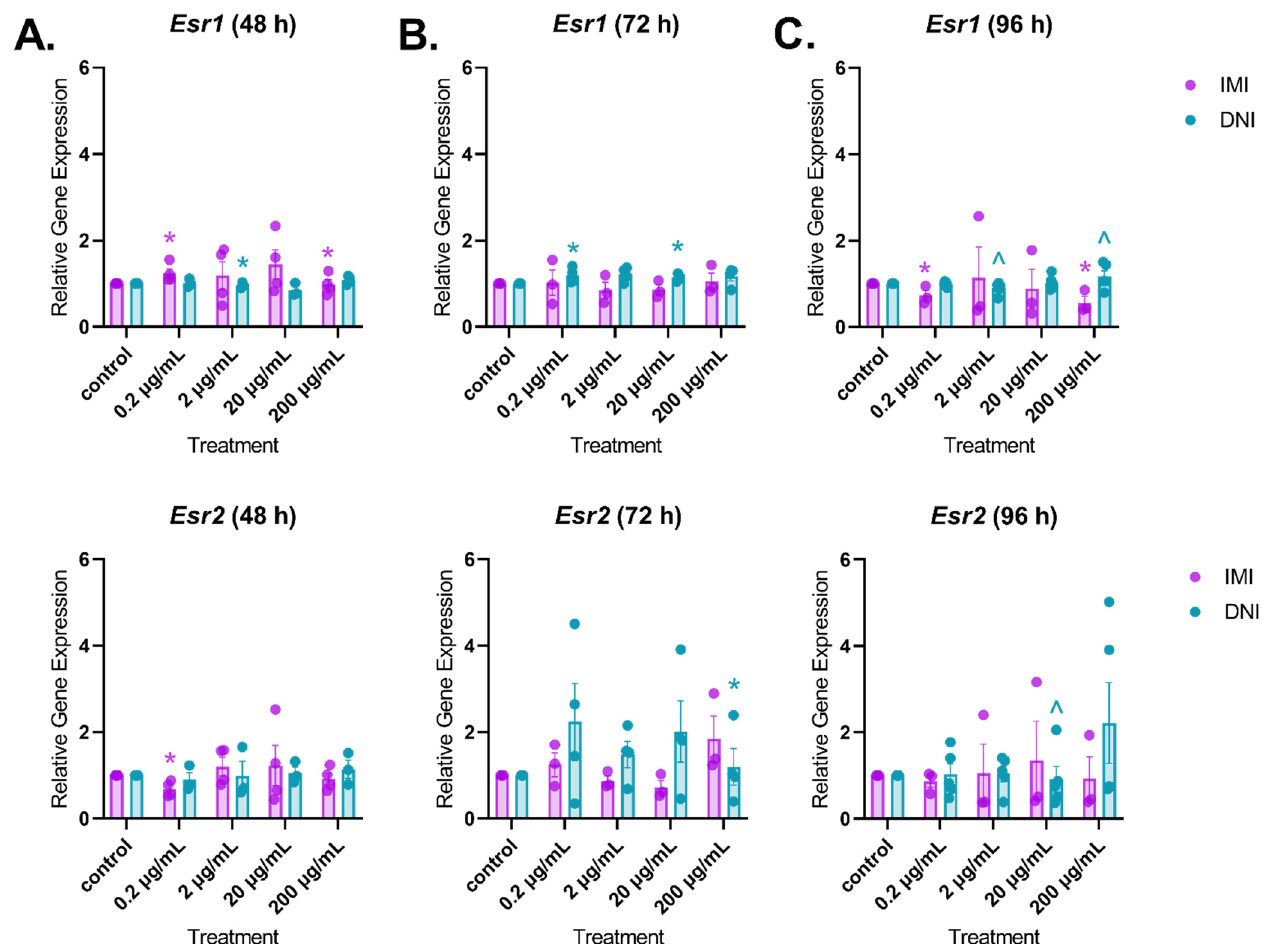
Figure 9. Effects of IMI and DNI on the gene expression of Esr1 and Esr2 in antral follicles treated with a vehicle (DMSO or water), IMI, or DNI (0.2–200 µg/mL) for 48 ( A ), 72 ( B ), and 96 ( C ) h. After the culture period, RNA was extracted from snap-frozen follicles, reverse-transcribed to cDNA, and subjected to qPCR. The graphs indicate means ± SEMs from 3–5 separate cultures (8–12 follicles per treatment per culture). * p < 0.05; ^ 0.05 < p < 0.10.